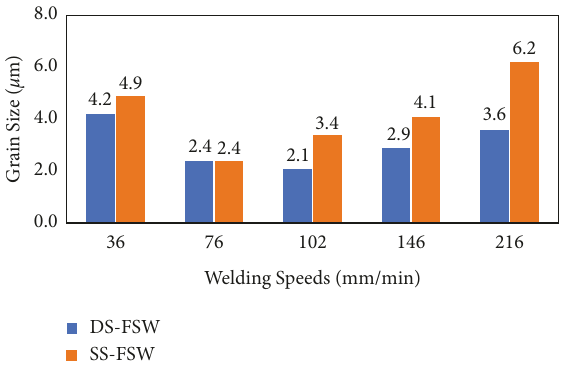
Figure 5: Average grain sizes of the stir zone for the FSW